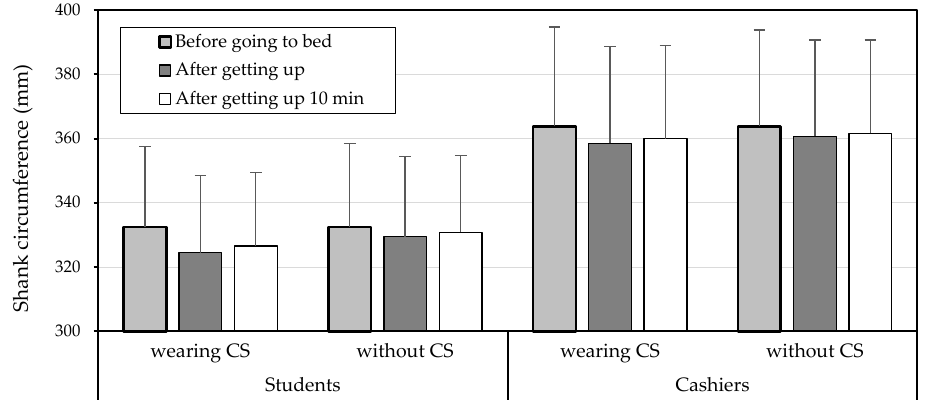
Figure 3. Shank circumference collected at varying time points under wearing and without compres- sion stockings (CSs) for two participant groups. Table 2. Main and interaction effects of shank circumference reduction obtained using three-way ANOVA.